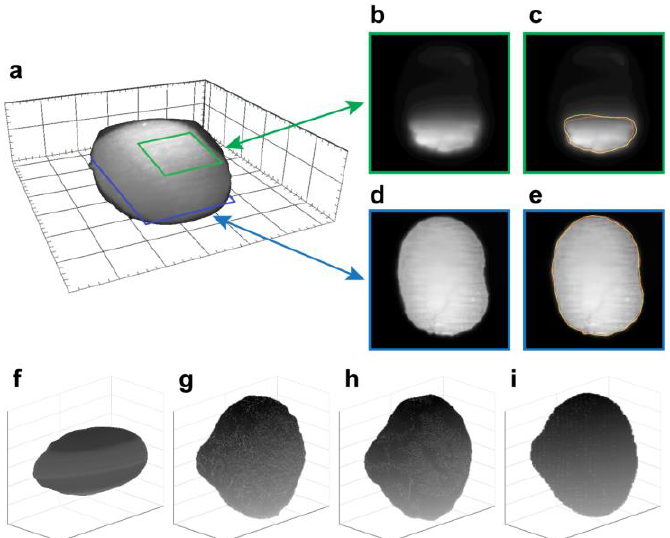
Figure 3. Segmentations and 3D surfaces. ( a ) apical (green) and equatorial (blue) planes of Multicellular Aggregate 1 (MA1); ( b , d ) original images coming from different z -planes of MA1. The blurriness of out-of-focus regions is strongly evident in ( b ), the image coming from the apical plane represented in green in ( a ); ( c , e ) contours of MA1 (reported in yellow and red), created by the same operator in different times. Very slight variations are visible between the yellow and red contours reported in ( e ), the image coming from the equatorial plane represented in blue in ( a ); ( f – h ) 3D surface of MA3, reconstructed by ReViSP , ReViMS , MITK , and OpenSegSPIM , respectively.